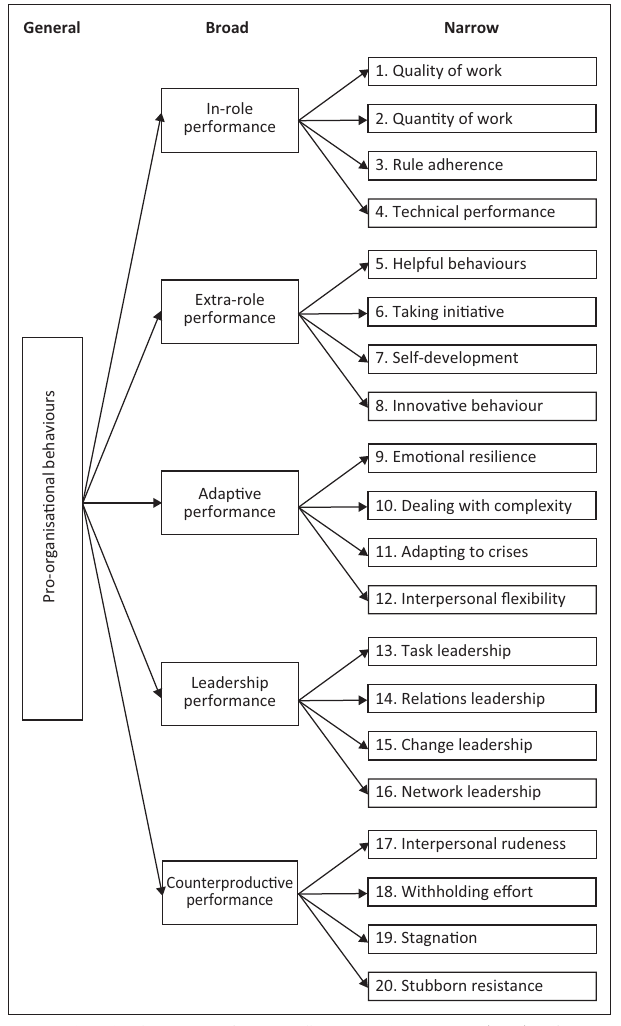
FIGURE 2: Broad and narrow dimensions of the Individual Work Performance